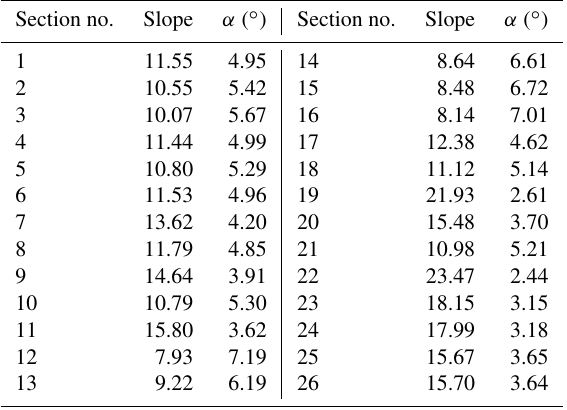
Table 3. Average beach slope on the analyzed days. Section no. Slope α ( ◦ ) Section